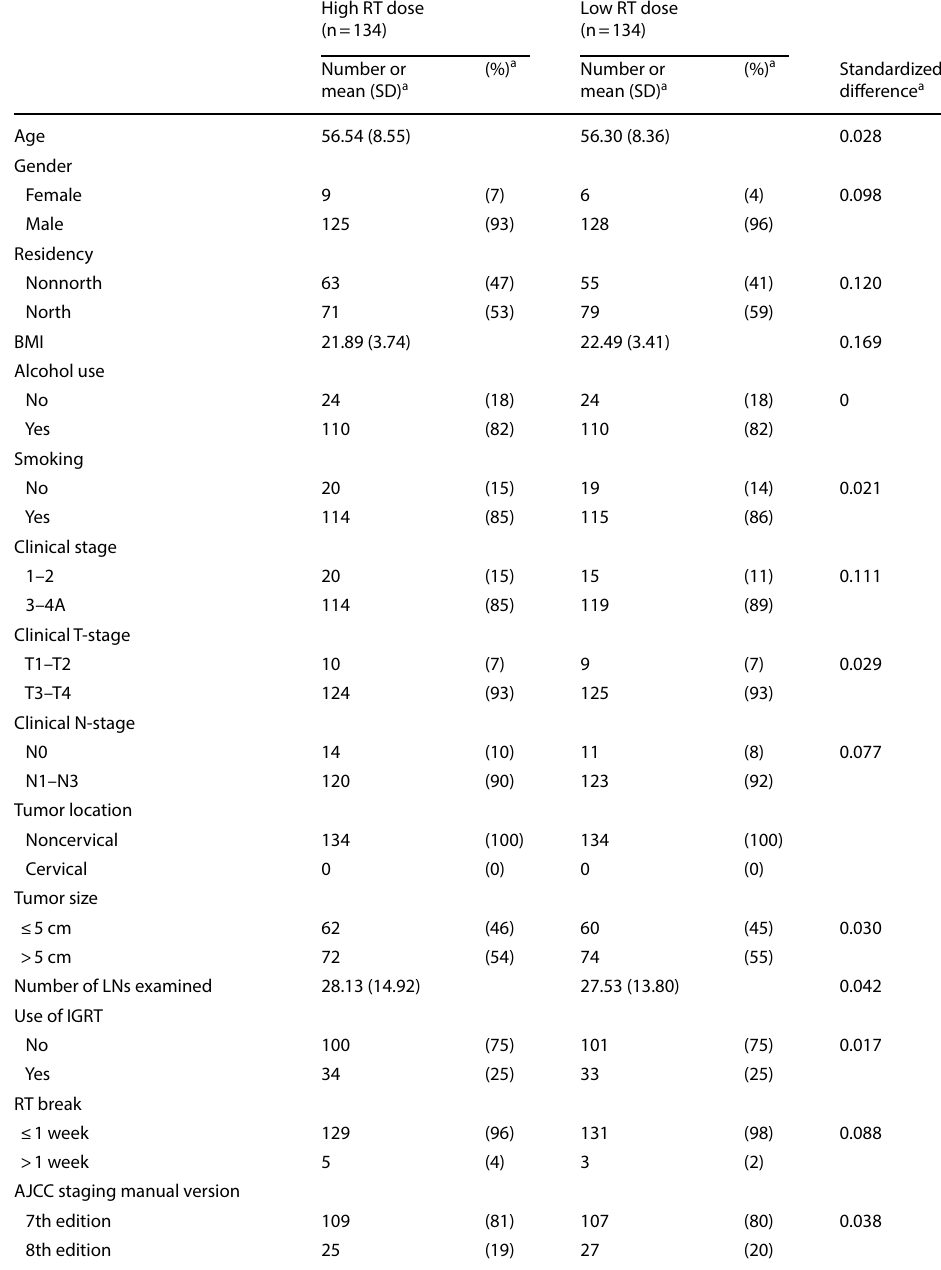
Table 2 Patient characteristics of the PS-matched